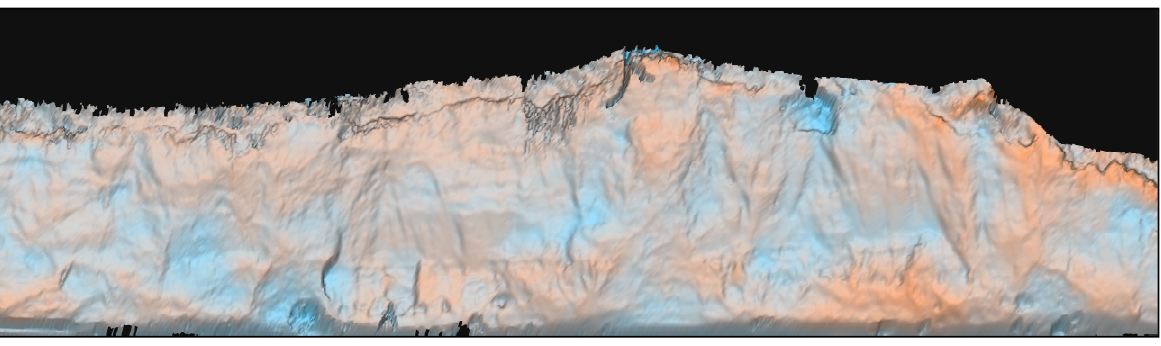
Figure 15. Time series change analysis using stop and go scanning for the Johnson Creek landslide along Highway 101 in Oregon. Orange indicates erosion and blue indicates accretion and seaward